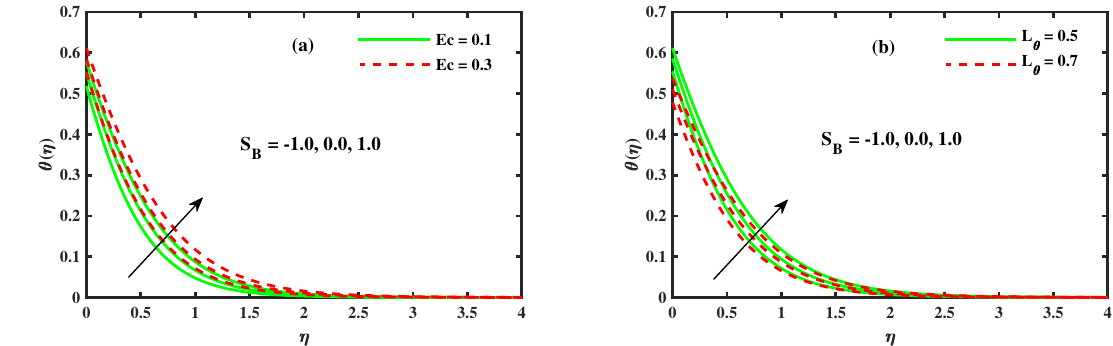
Figure 7. The impact of θ ( η ) for ( a ) Eckert number Ec and ( b ) thermal slip L θ .